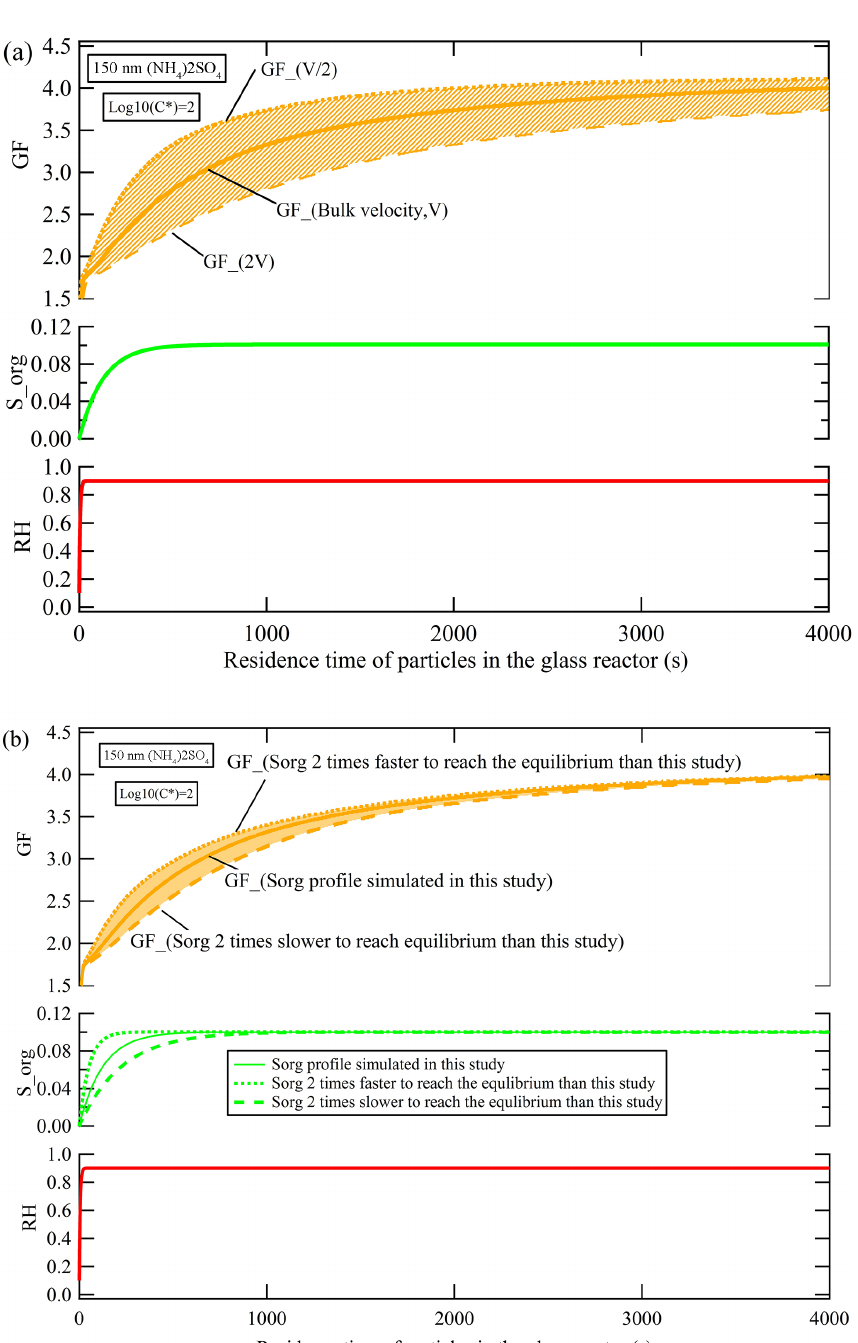
Figure 9. Simulated GF with residence time for organics with log 10 (C ∗ ) = 2: sensitivity to (a) axial variability and (b) radial